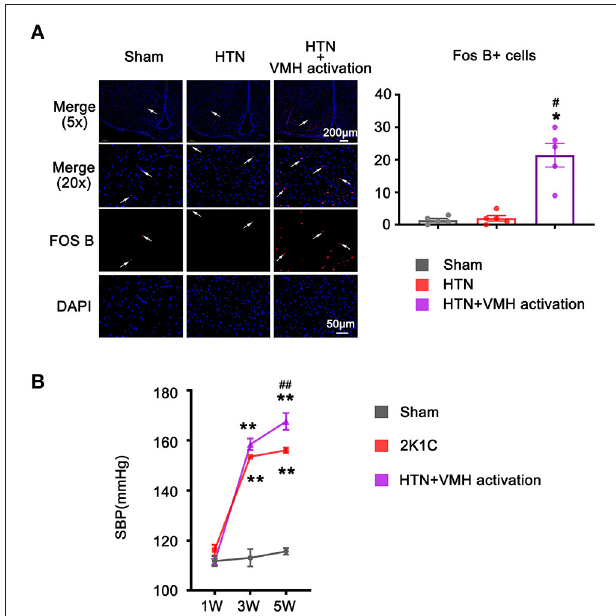
FIGURE 2 | The increase of FOS B expression and systolic blood pressure after VMH activation. (A) Representative images (5x and 20x) and quantification of Fos B expression in the VMH. The scale bar represents 200 µ m and 50 µ m. Values are presented as mean ± SEM ( n = 5 per group); (B) SBP was measured at 1W, 3W, and 5W. Values are presented as mean ± SEM ( n = 6 per group). VMH, ventromedial hypothalamus; SBP, systolic blood pressure; * p < 0.05, ** p < 0.01; vs. sham group; # p < 0.05, ## p < 0.01 vs. HTN